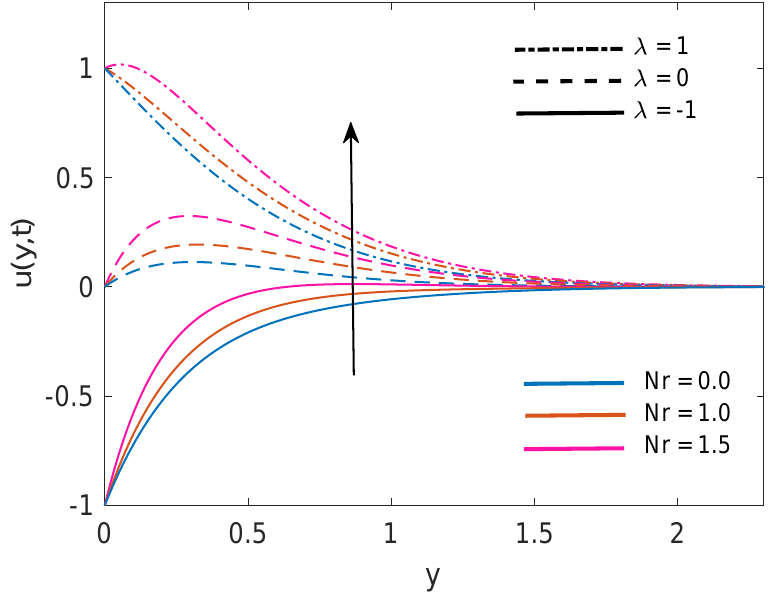
Figure 7. Variation in velocity profile for different Nr when Gr = 5, K = 5, Q = 0.5, M 2 = 5, φ = 0.1 and t =